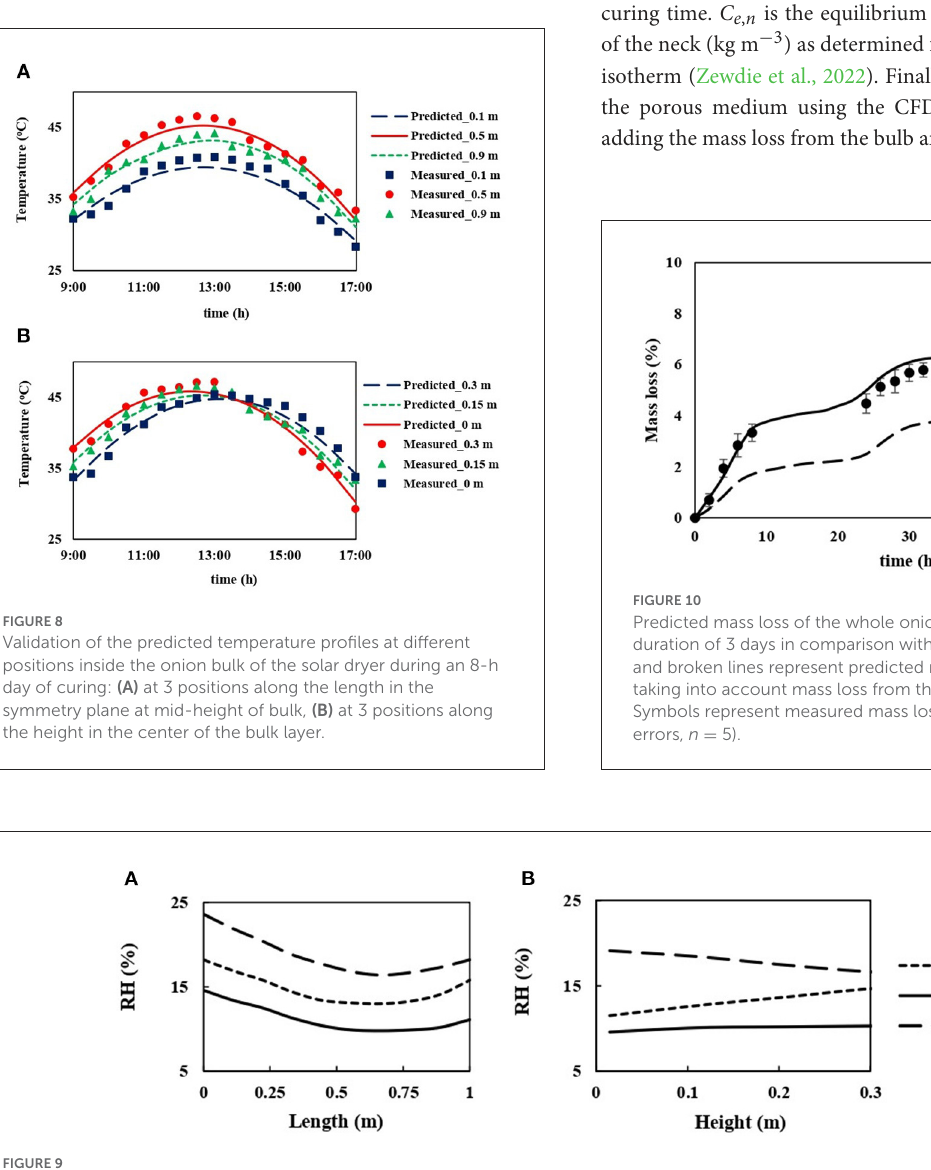
FIGURE9 Predicted relative humidity of the air in the onion bulk layer of the solar dryer as a function of time of day (A) along the length at mid-height of the bulk layer, (B) along the height in the center of the bulk layer.